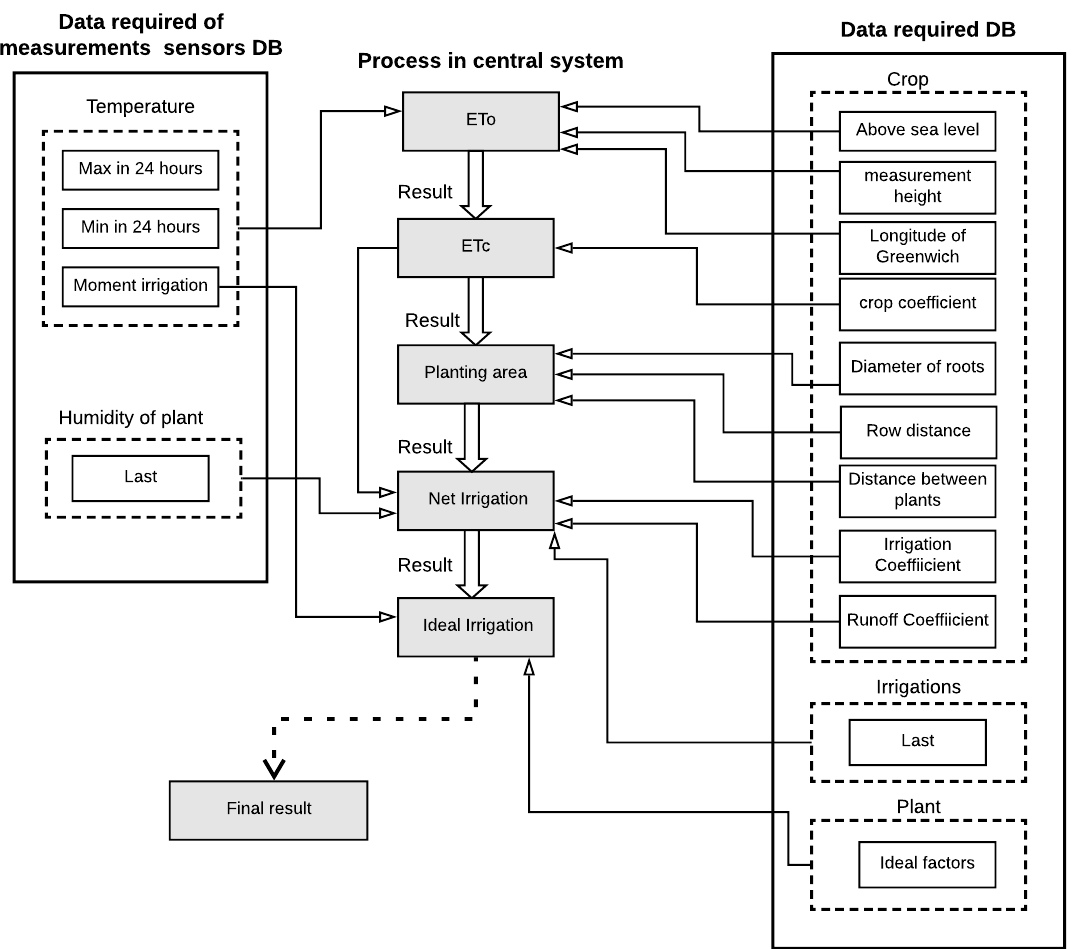
Figure 3: Process and Data to Water